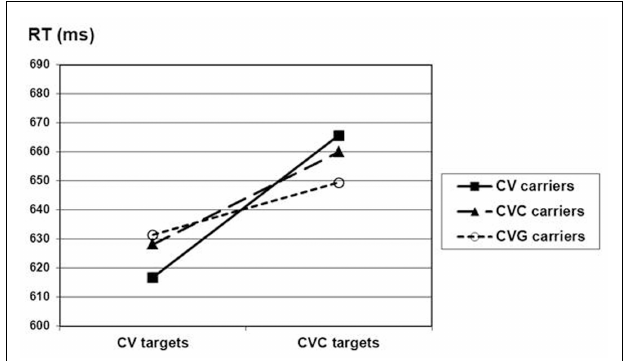
FIGURE 1 | Experiment 1, mean RTs (ms) as a function of target type (CV or CVC) and carrier type (CV, CVC, or